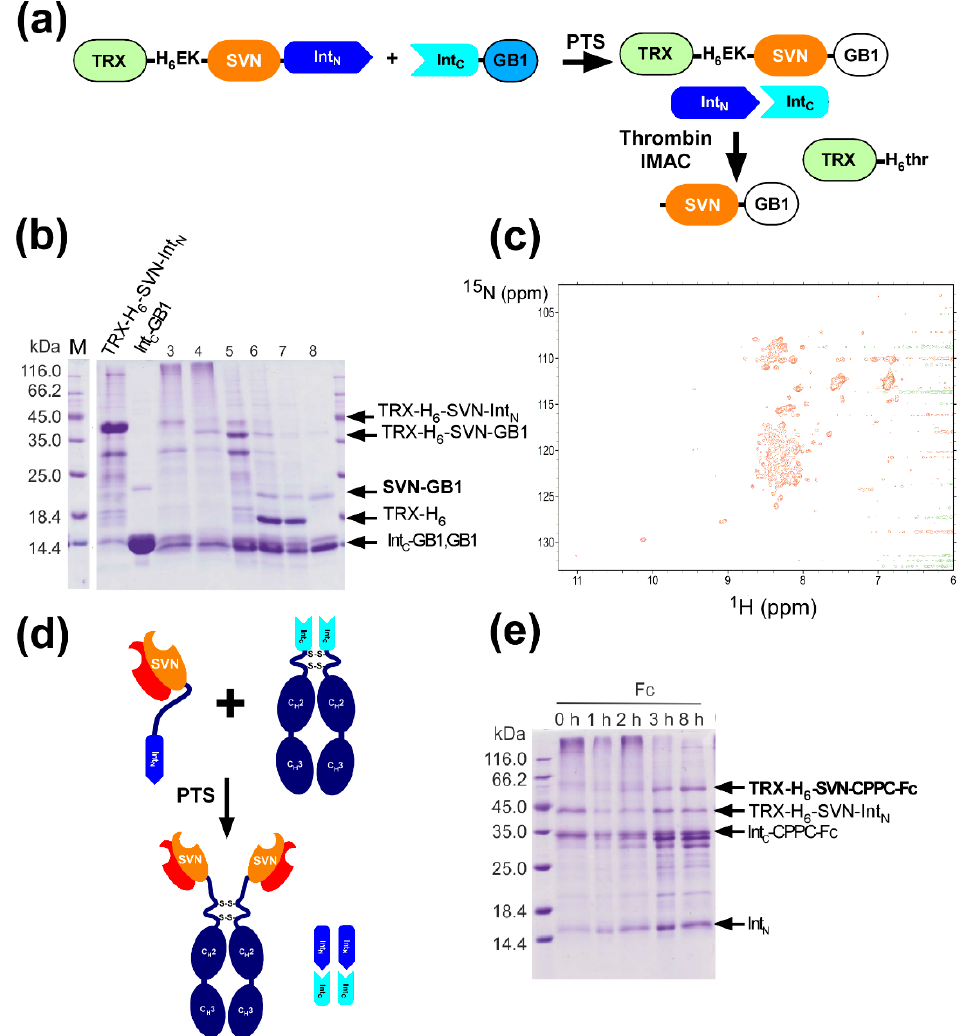
Figure 6. A lectin fusion protein, ‘lectibody’ ( a ) Schematic drawing of the ligation of a lectin (SVN) with a model protein (GB1) by PTS. ( b ) SDS-PAGE analysis of the protein ligation of SVN and GB1. The first two lanes show separately prepared N- and C-precursor proteins (TRX-H 6 -SVN-Int N and Int C -GB1). Lanes 3 and 4 show the ligation reaction immediately after the mixture and after 8 h of incubation, respectively. Lane 5 and 6 indicate samples before and after the proteolytic digestion by enterokinase (EK), respectively. Lanes 7 and 8 show samples before loading on a protein A sepharose column and the elution fraction from the column, respectively. ( c ) [ 1 H, 15 N]-HSQC spectrum of the segmentally isotopic labeled [ 15 N]-SVN-[ 14 N]-GB. ( d ) Schematic drawing of the production of SVN-Fc fusion by PTS. ( e ) SDS-PAGE analysis of the time-course of the ligation between TRX-H 6 -SVN-Int N and Int C -CPPC-Fc by